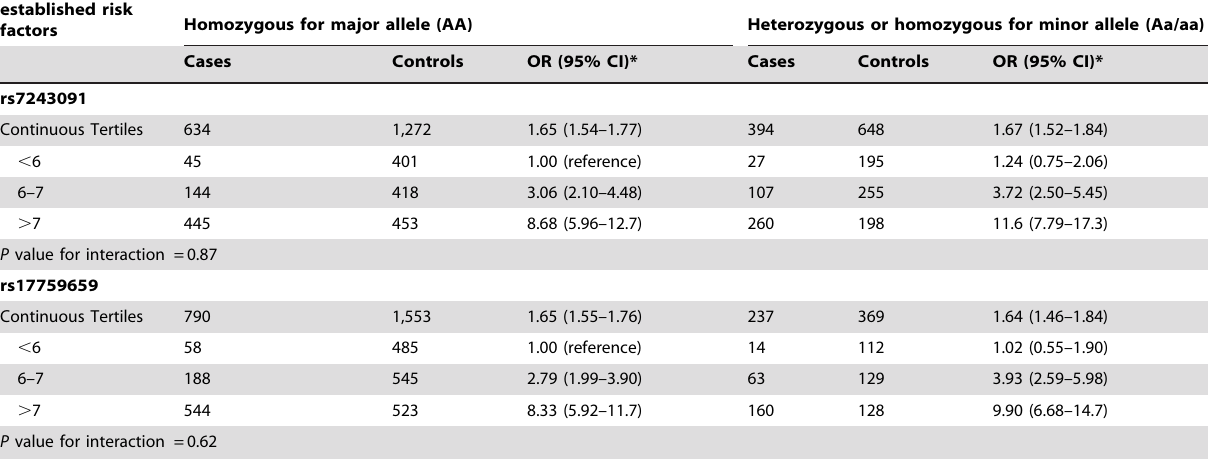
Table 4. Effects of BCL2 gene variants on associations between risk scores for established risk factors and endometrial cancer risk, the Shanghai Endometrial Cancer Genetics Study